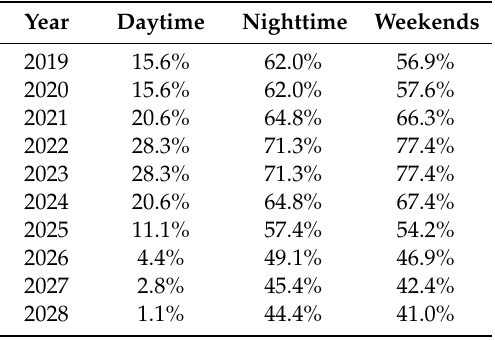
Table 5. Marginal plant probability profile of coal generators, 2019–2028.